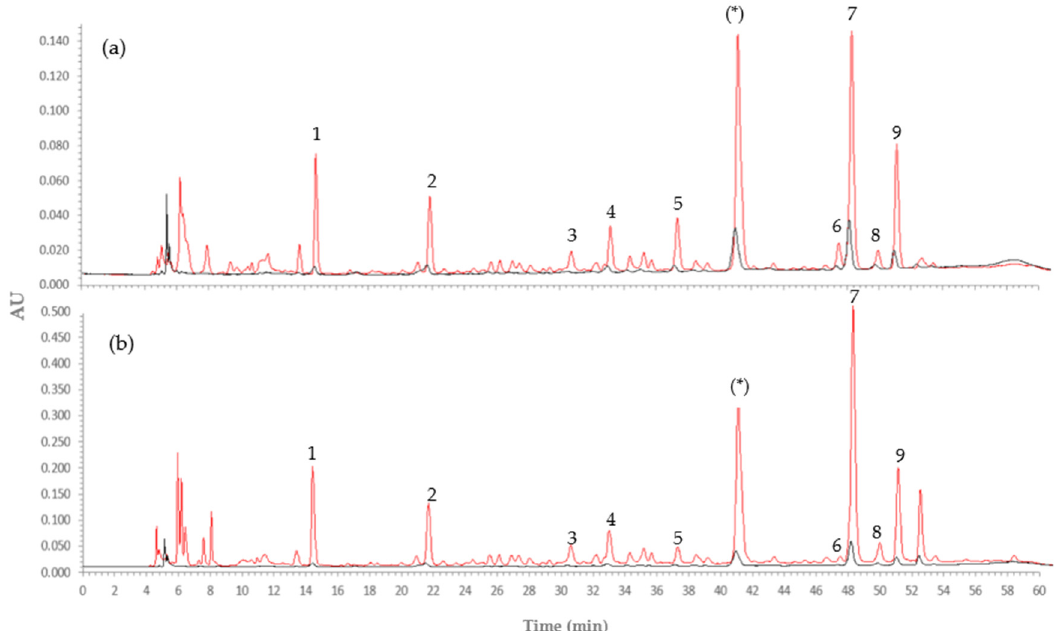
Figure 4. HPLC chromatograms of phenolic compounds detected. ( a ) In water extract W/FD (red line) and in particles with encapsulated water extract W/FD (black line); ( b ) in E:W 80:20 extract (red line) and in particles with encapsulated E:W 80:20 extract (black line). 1. Gallic acid; 2. Hydroxytyrosol; 3. Chlorogenic acid; 4. Dihydroxicaffeic acid; 5. Caffeic acid; 6. P-coumaric; 7. Ferulic acid; 8. Myricetin; 9. Isoferulic acid; (*) unidentified compound. Table 6. Quantification of phenolic compounds in the extracts of pineapple peel (mg/100 g dry matter (DM)) and in particles from spray drying (mg/g particles).